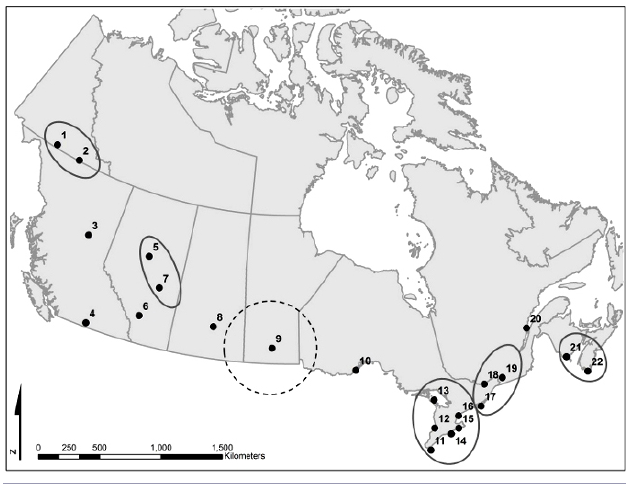
Fig. 1 . Canadian Migration Monitoring Network stations where samples were collected for this study. See Table 1 for key to station names. Ovals indicate stations that were combined into regions for certain analyses and maps (Table 1). The dashed circle shows a radius of about 900 km around station 9, to illustrate the size of the 7.5 degree radius zones used to define direction of migration (see Methods.)